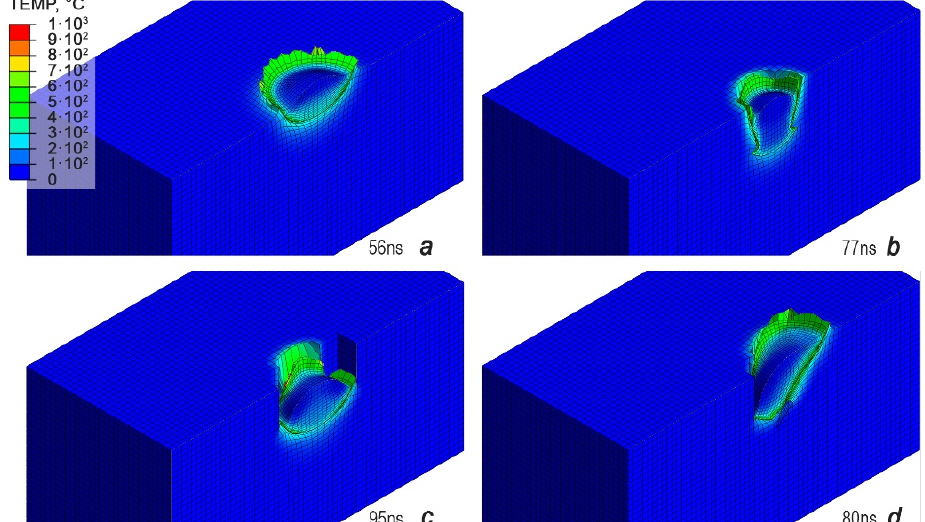
Figure 7. Temperature distribution of the particle ( d P = 50 µ m) and substrate at the end of collision: ( a ) without microdefect; ( b ) with cube-shaped microdefect; ( c ) with rectangular-shaped microdefect; ( d ) with the particle collision on the edge of cube-shaped microdefect.